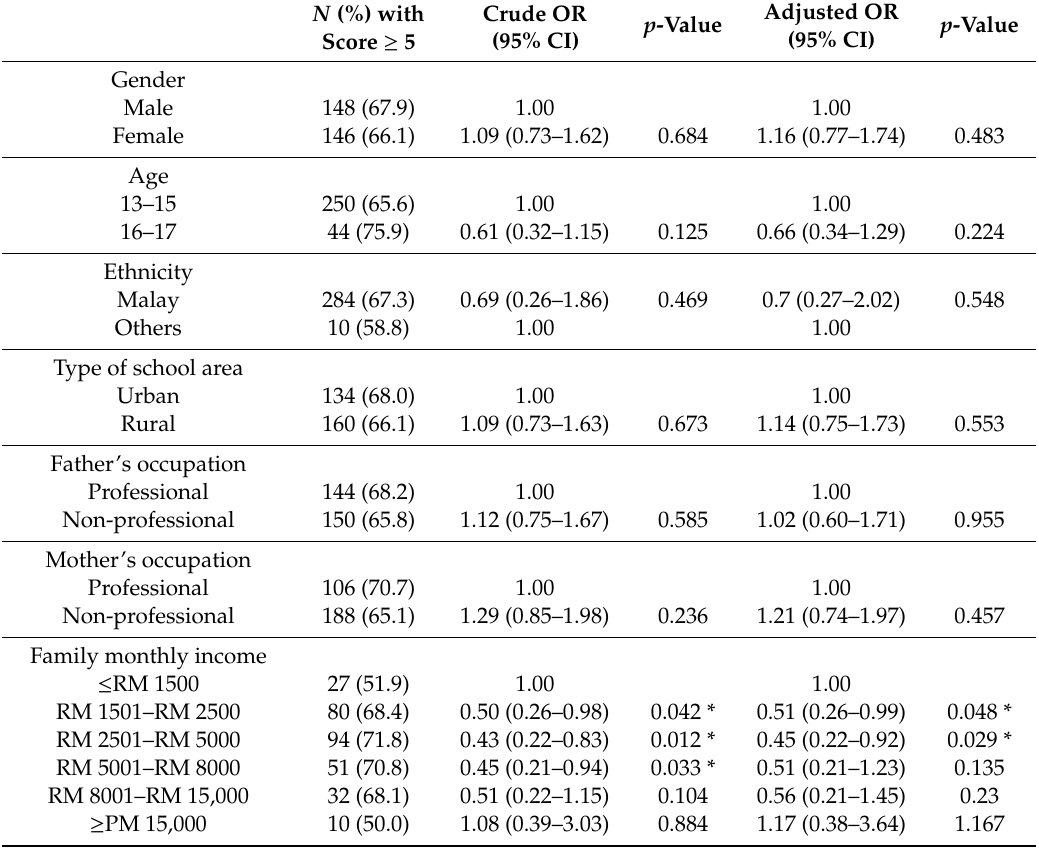
Table 4. Bivariable and multivariable logistic regression predicting knowledge on SSB among participants, ( N =